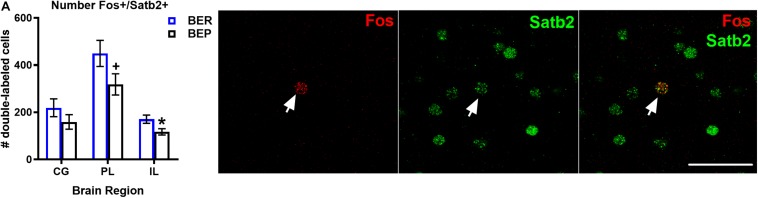
Total numbers of PF-activated excitatory neurons in the mPFC of BEPs and BERs. Values for # of double labeled cells in BEPs and BERs (A) represent ANCOVA-adjusted means, using PF consumed prior to sacrifice as the covariate, for each brain region. Error bars represent 1 SEM. Image panel depicts a Fos+ neuron co-localized with Satb2; scale bar represents 50 um. ∗p < 0.05, +p < 0.09.